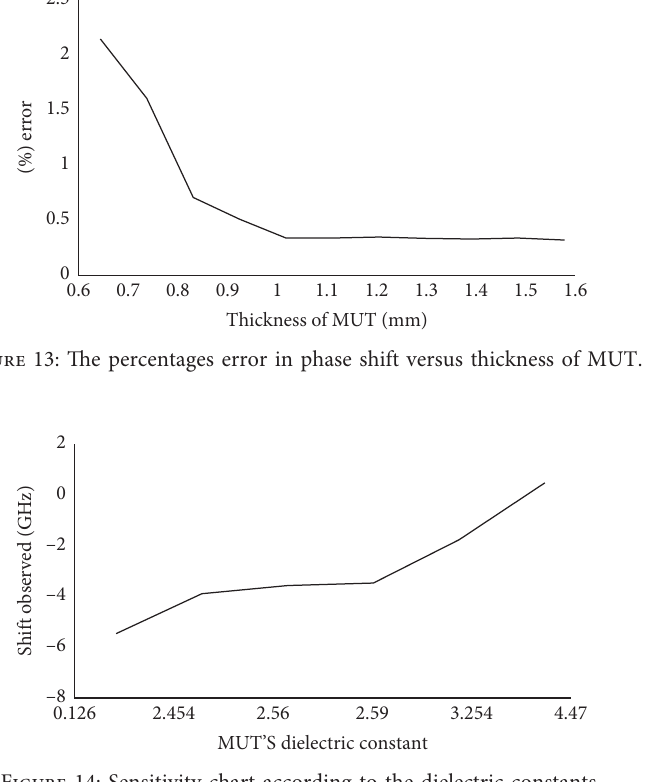
Figure 14: Sensitivity chart according to the dielectric